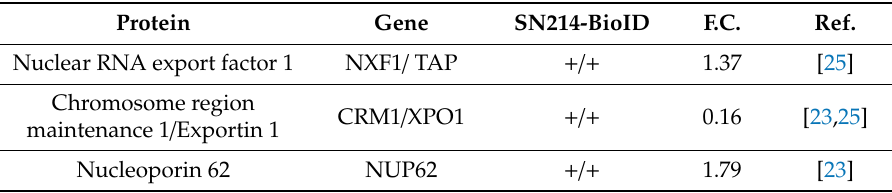
Table 2. List of validated SET-NUP214 interaction partners found in the biotinylated fraction of